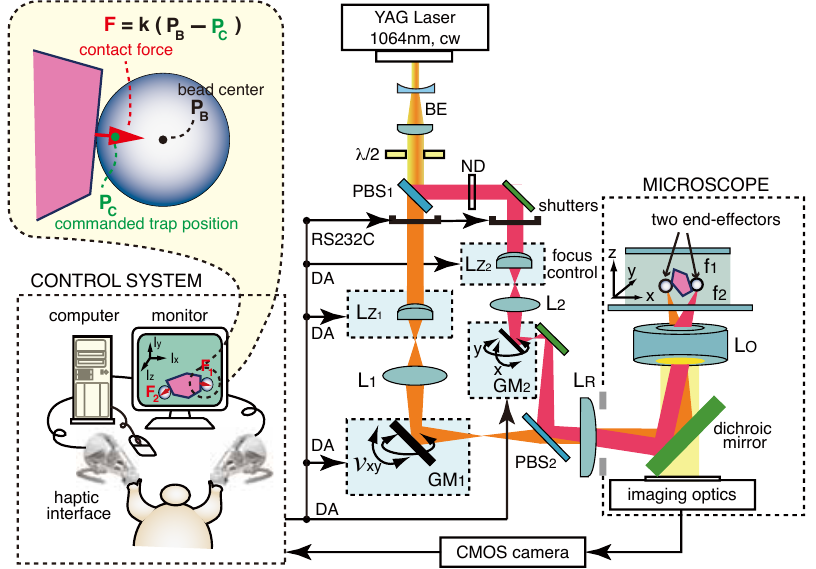
Figure 1. Schematic of dual-arm visuo-haptic 3D optical tweezer system that can represent the forces during indirect micromanipulation with two